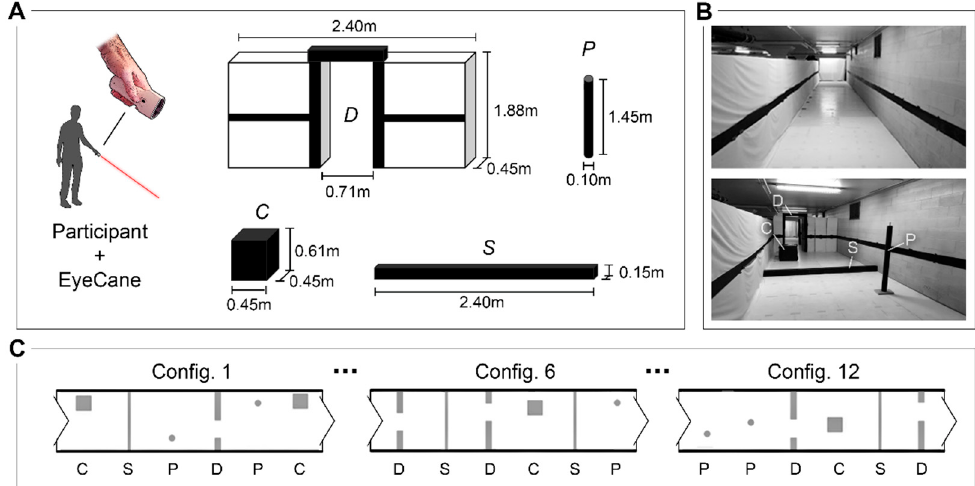
Figure 2. The experimental setup and procedure. ( A ) A participant handling the EyeCane in a downward directed manner; four type of obstacles: D= door, P = post, C = cube, and S = step. ( B ) At the top, a photograph of the empty obstacle course and at the bottom an example of obstacle placement. ( C ) Three schematic representations of the twelve different trial configurations.